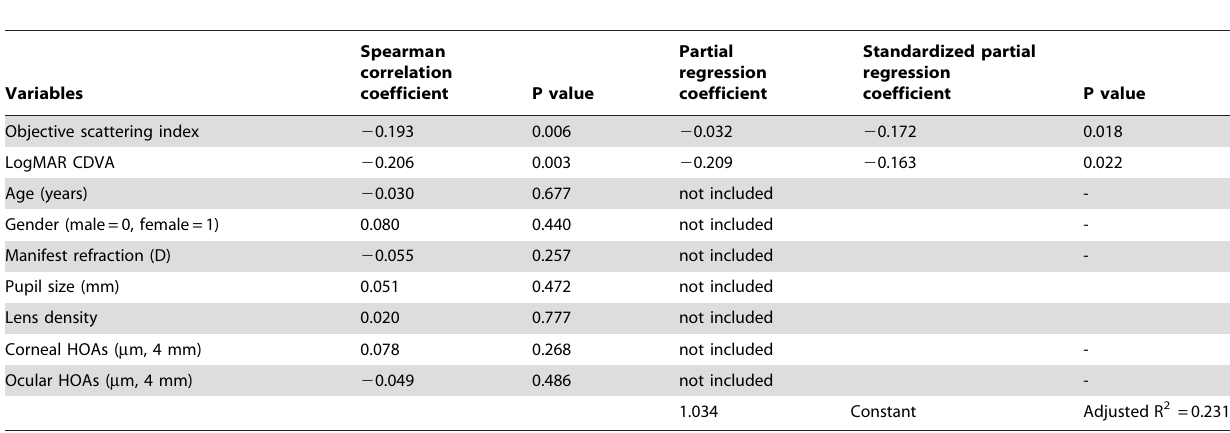
Table 2. Results of correlation analysis and stepwise multiple regression analysis to select variables relevant to the area under the log contrast sensitivity function in myopic subjects.